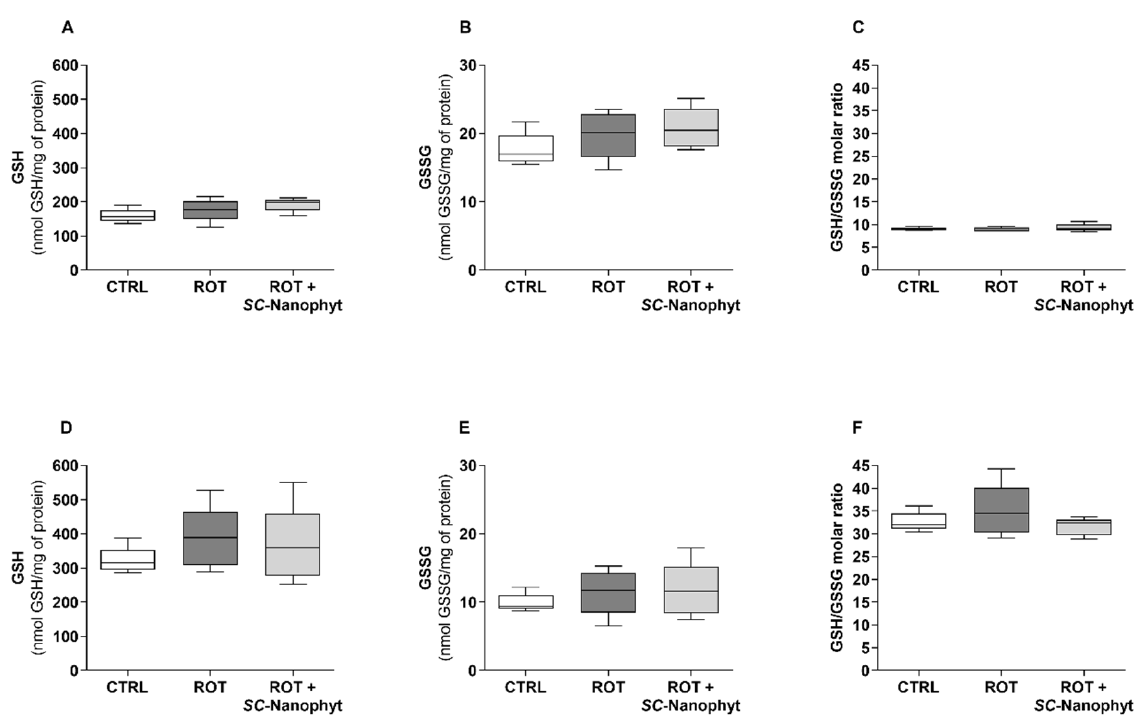
Figure 8. GSH ( A , D ) and GSSG ( B , E ) levels and GSH/GSSG molar ratio ( C , F ) in the mitochondria- free cytosolic fraction from BG-Cereb ( A – C ), and C-Cortex ( D – F ) brain portions of CTRL, ROT and ROT + SC -Nanophyt groups. Error bars represent SEM for n = 5 independent experiments using five animals in each one.